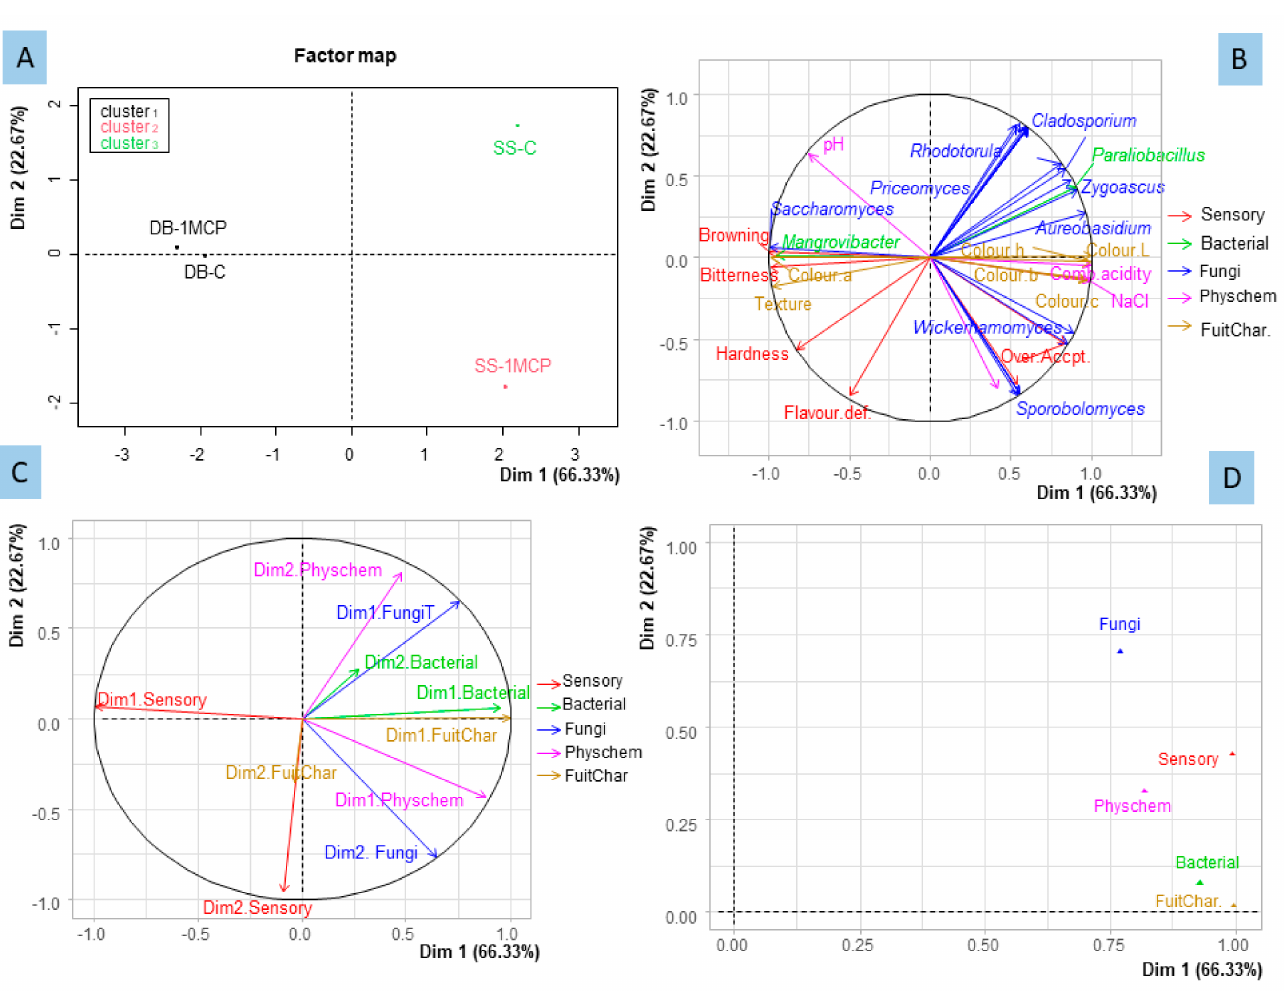
Figure 5. Factor map of treatments on the plane of the first two overall dimensions, showing simultaneously their automatic clustering ( A ), correlation circle of different sensory, microbial, physic- ochemical, and fruit characteristics ( B ), comparison of the alignment of overall and each group’s first two dimensions ( C ), and projection of the groups on the plane of the first two overall dimensions ( D ). The analysis was based on the average values per treatment of the different